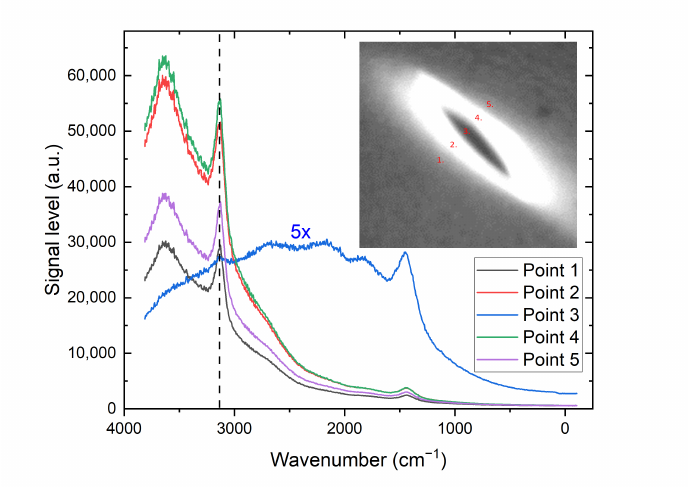
Figure 3. Raman spectra collected in five locations, shown in the inset, at spot 8 of HEN2. The signal for location 3 was magnified five times for clarity. The vertical dashed line represents the peak of the Zero Phonon Line (ZPL) for the nitrogen-vacancy color center (3132 cm − 1